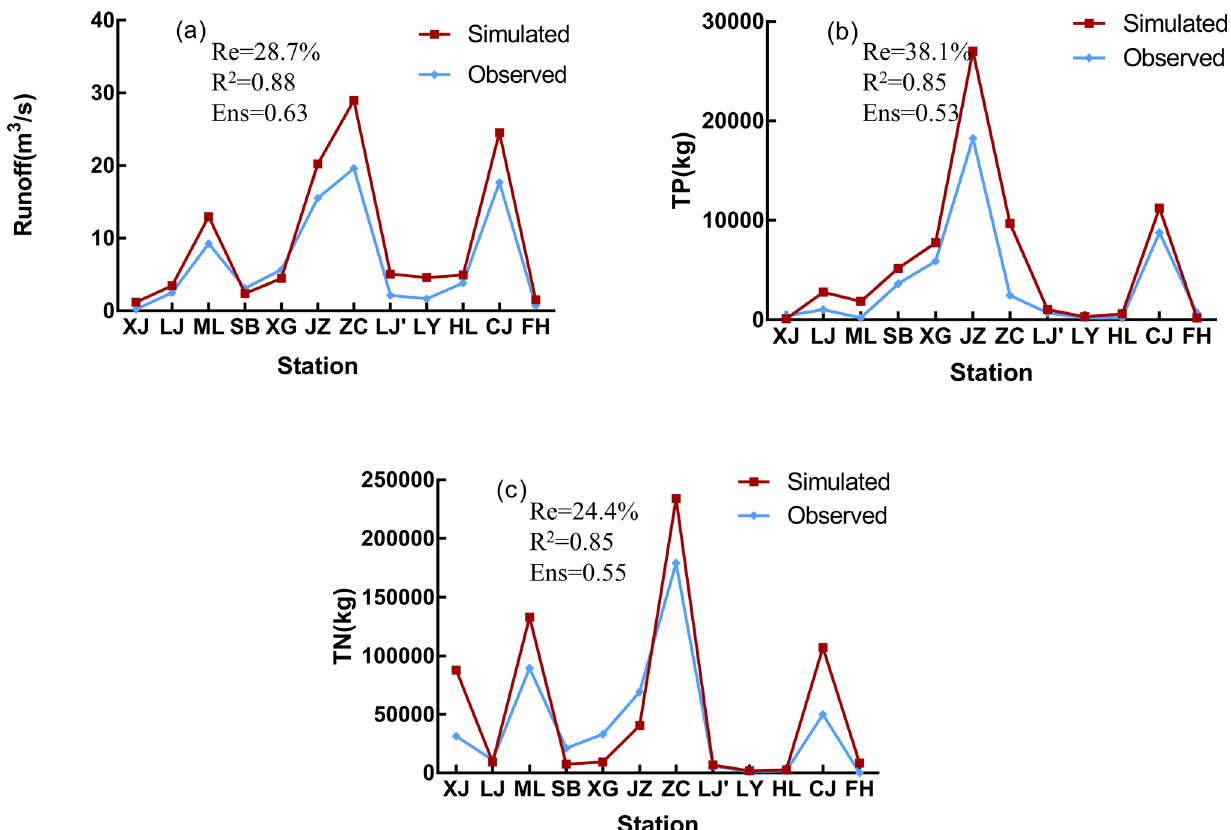
Fig. 6 Comparison between observed and simulated values of each verification station: a runoff; b TP; c